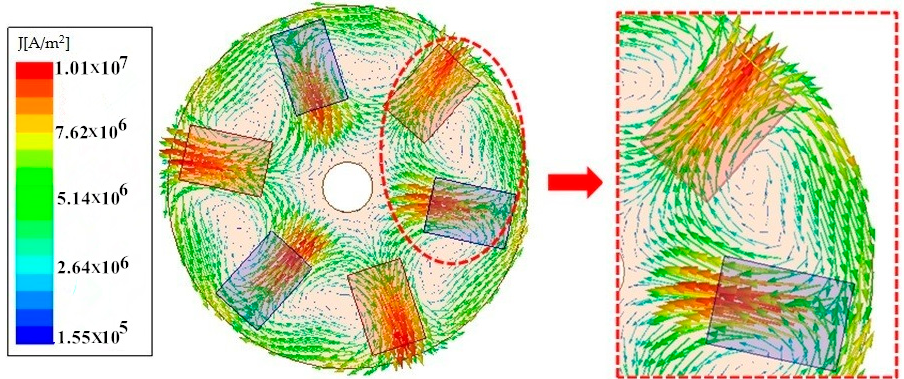
Figure 3. Distribution vector diagram of induced eddy current in the copper disk.